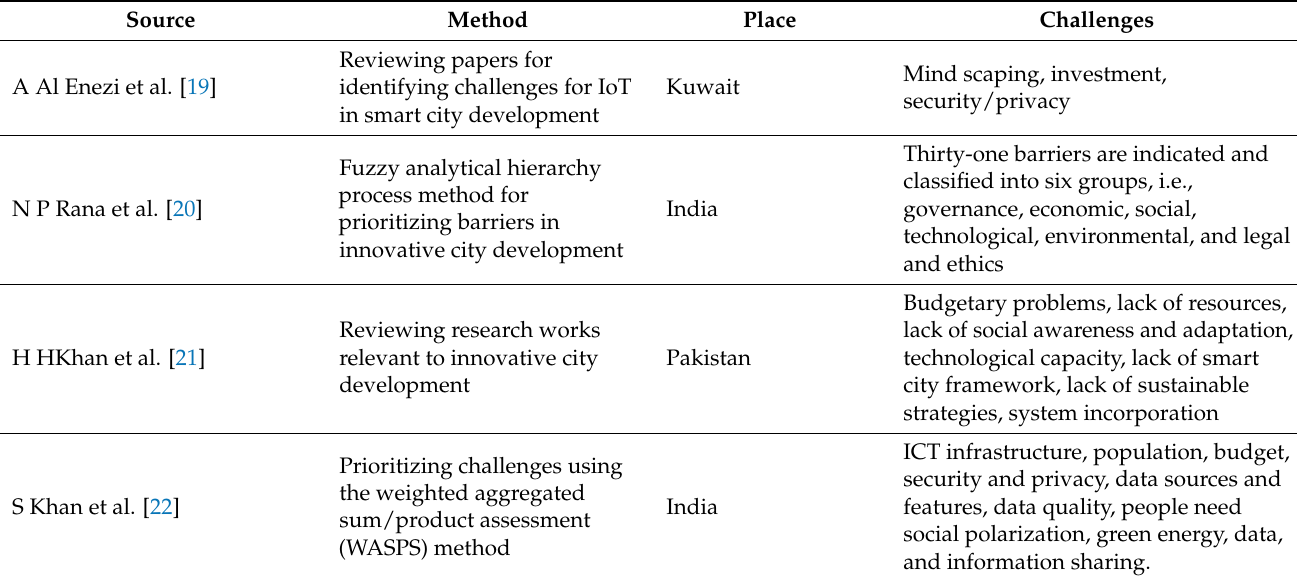
Table 1. Challenges of smart city development in different